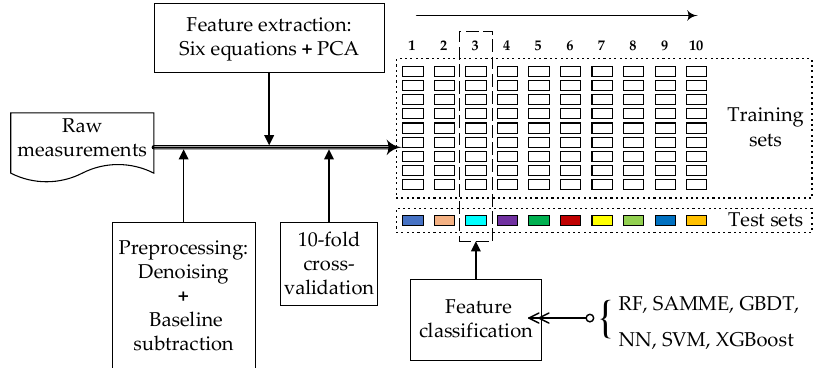
The procedure for the comparison experiments is shown in Figure 2. When the gaseous perfumes pass by the gas chamber, the sensing voltages of the sensor array are sampled to provide the raw measurements. As perfume samples, we used four types of perfumes with different fragrance notes. In each sampling cycle, the volume of perfume used was fixed at 3 µ L. The time span for each sampling cycle was 50 s. After each sampling cycle, the gas links and chamber were washed for 15 min. To obtain sufficient experimental instances, the number of sampling cycles for each perfume was set as 30. Therefore, as raw measurements, we obtained a set of 120 sampling instances.